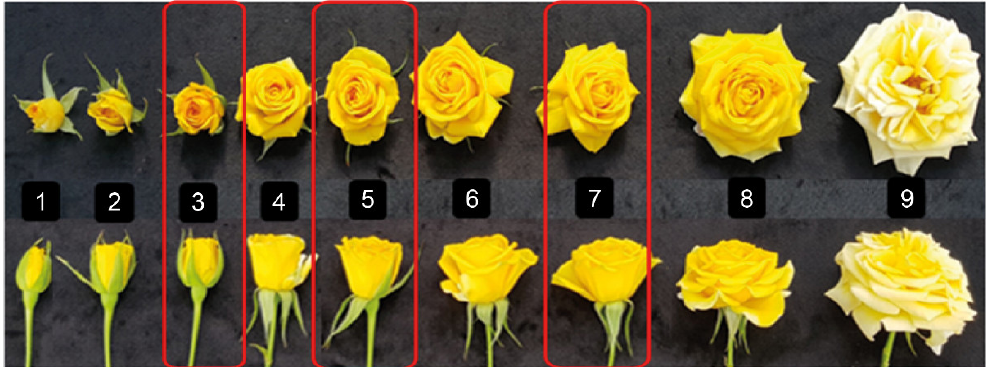
Figure 1. Photos of each variety of roses selected for the experiment. Standard type: ( a ) ‘Green Star’, ( b ) Red Square’, ( c ) ‘Shooting Star’, ( d ) ‘Mystic Blue’, ( e ) ‘Tineke’; spray type: ( f ) ‘A-Pink’, ( g ) ‘Sunny Lady’, ( h ) ‘Ever Spring’, ( i ) ‘Vivien’, ( j ) ‘Red Pop’.